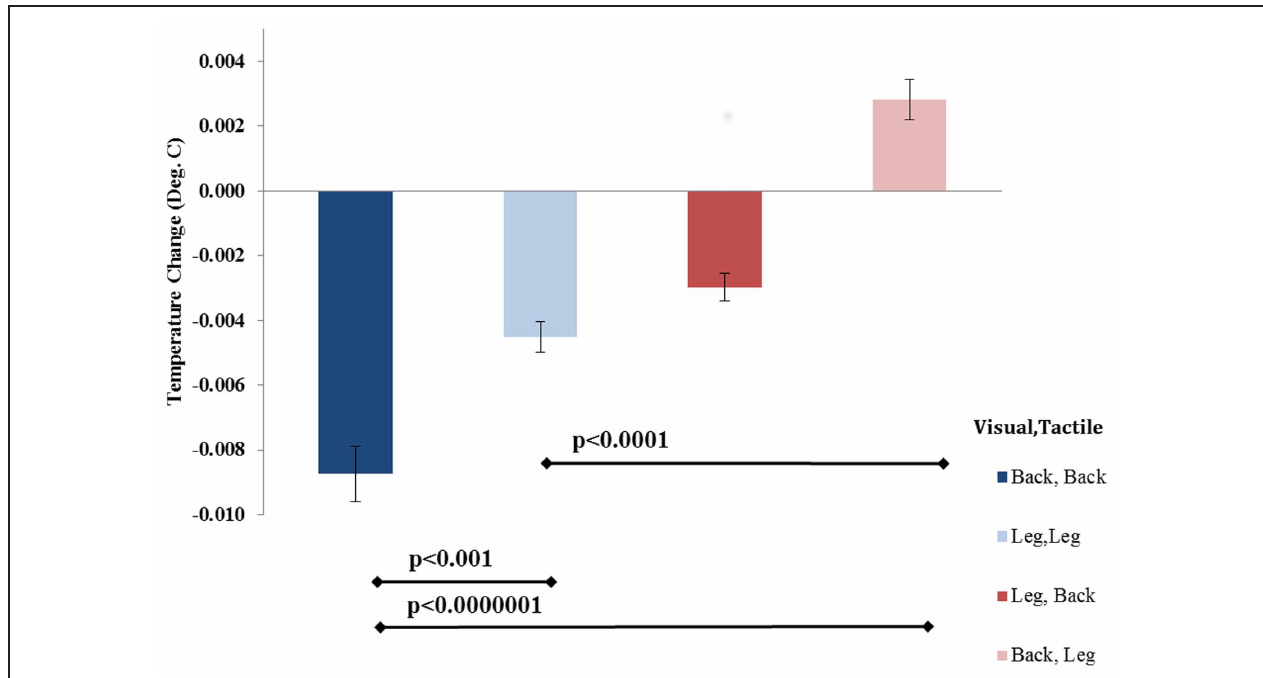
FIGURE 4 | Temperature data in all conditions. Temperature changes across four locations and across all time points (mean ± standard error). N = 17.